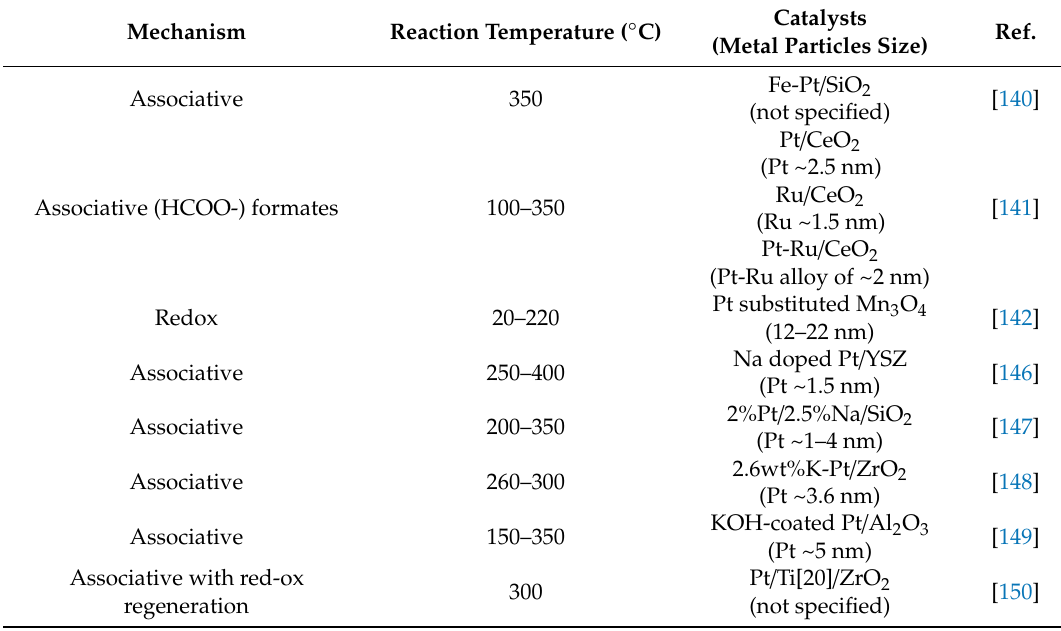
Table 9. Summary of the mechanism reported in Section 4.2: Polymetallic and Promoted